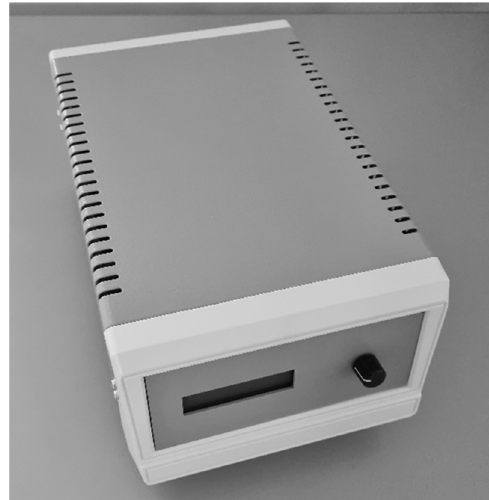
Figure 1. The model nanoparticle detector.